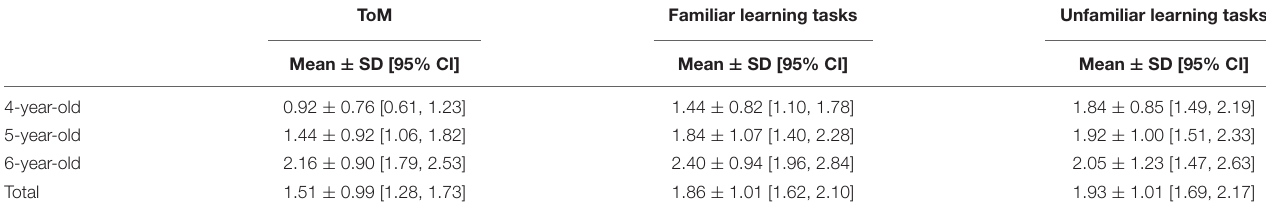
TABLE 1 | Descriptive statistics of Study 1.